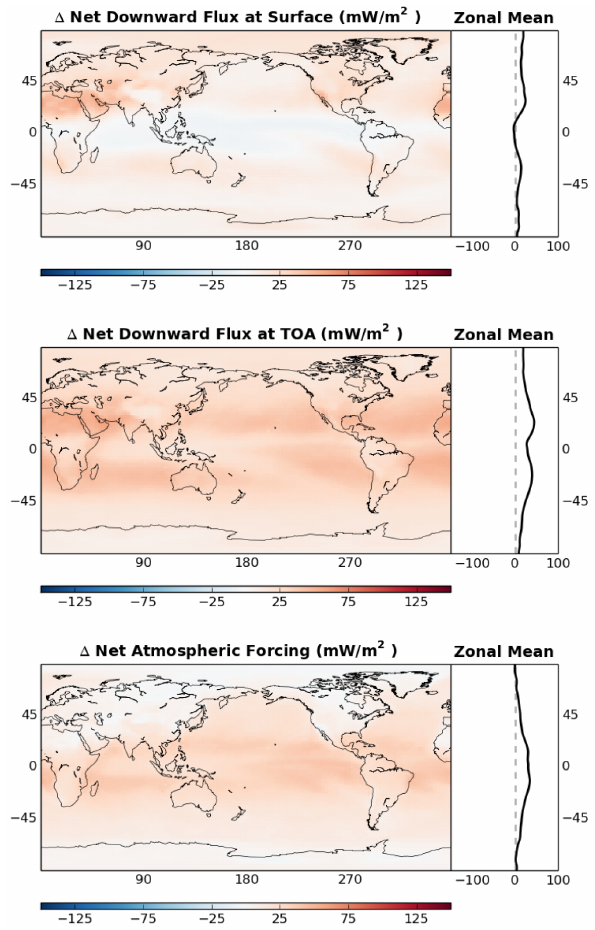
Figure 3. Annual averaged instantaneous radiative forcing, in mWm − 2 , at the surface (top) and top of the model (middle) for ozone. Net downward atmospheric forcing is shown in the bottom plot for ozone. Unlike the chemical mechanism evaluation, this sim- ulation spanned a full year to enable an annual averaged calculation.